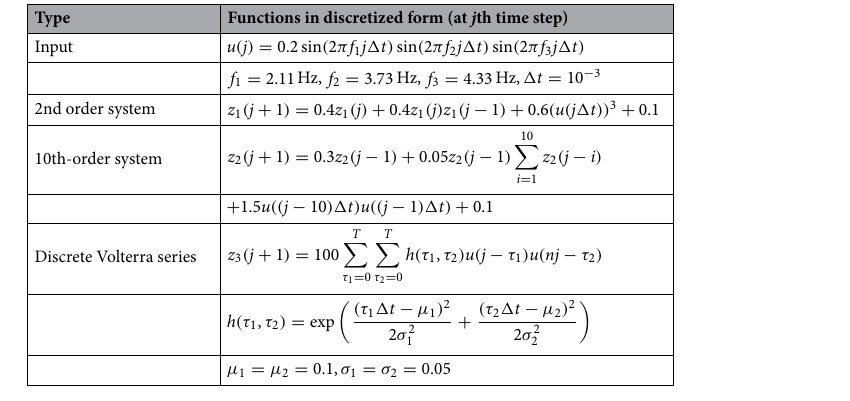
Table 2. Emulation task functions.